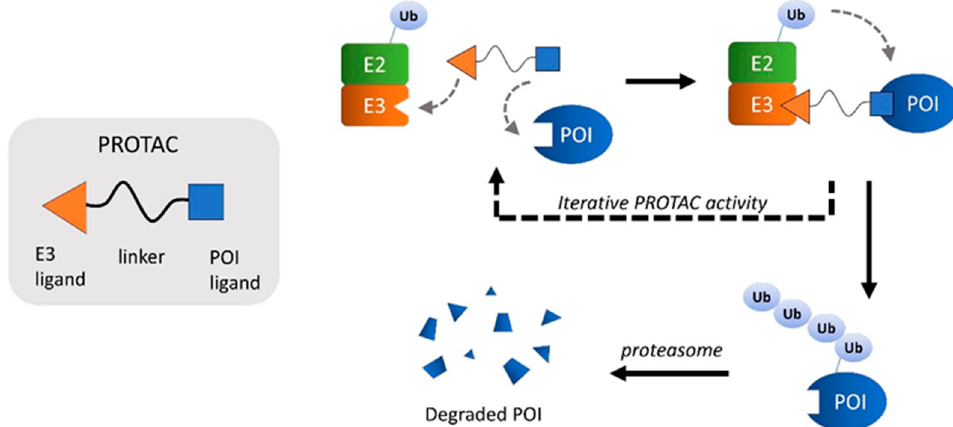
Figure 5. General mechanism of action of PROTACs. PROTACs are drug-like compounds comprising two active ends joined by a linker. The ends are specific ligands able to recognize and “hook” an E3 ligase and a protein of interest (POI). Upon binding, PROTAC induces the formation of the ternary complex E3 ligase/E2-Ub/POI, thus favoring POI ubiquitination and, consequently, degradation by the proteasome.